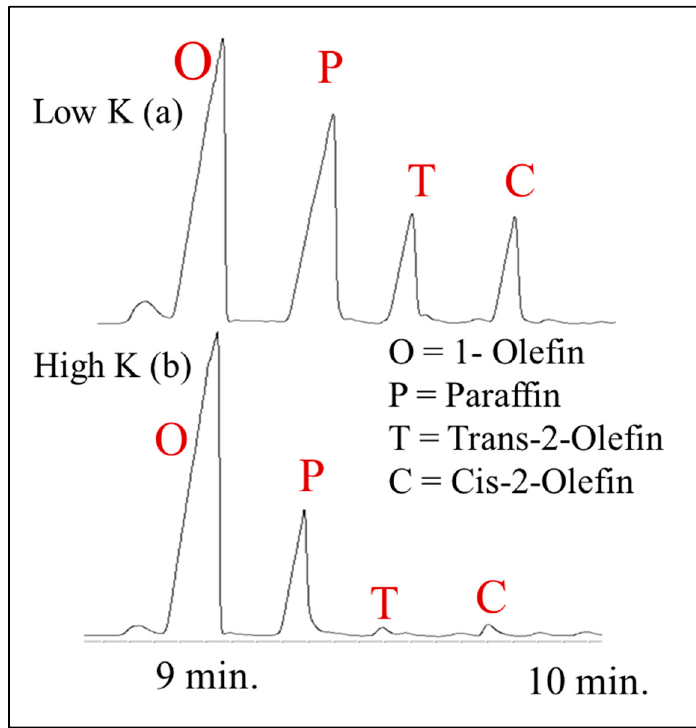
Figure 28. A zoomed in chromatographic picture to display the difference in the main products fraction by the addition of different atomic ratios of K. “Low” is less than 2, (i.e., 2K100Fe), whereas “High” is greater than 2. This figure was built from 9 iron runs (with combinations of Cu, Si and K) catalyst runs that deviated one component while leaving the other two constant (e.g. K was varied while Si and Cu remained constant). The O/P ratio and the 1-olefin/2-olefin ratios only changed by varying K in the recipe. Furthermore, only when K ≥ 2, (2 and 5 atomic ratios) and K < 2 (0.5, 1, and 1, 25 atomic ratios) did these ratios change. Reaction Conditions were 270 °C, 12.1 bar, WHSV = 2, and H 2 /CO = 0.7.